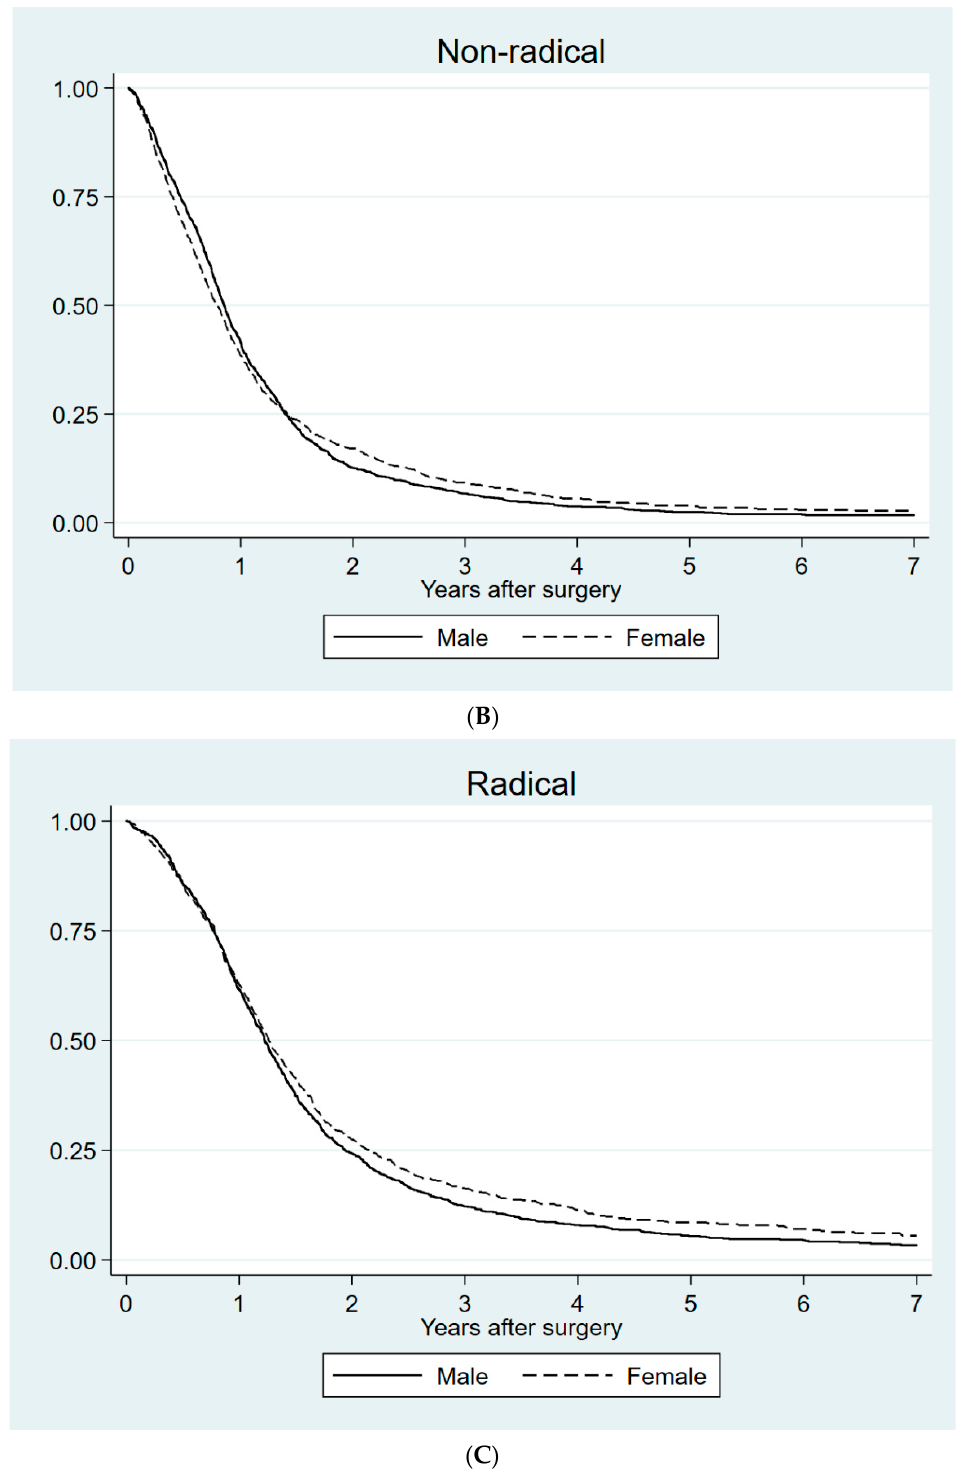
Figure 4. Survival for men and women with different types of diagnostic surgery. ( A ) Biopsy ( p = 0.86); ( B ) partial resection ( p = 0.66); ( C ) radical resection ( p = 0.045) using Kaplan–Meier sur- vival